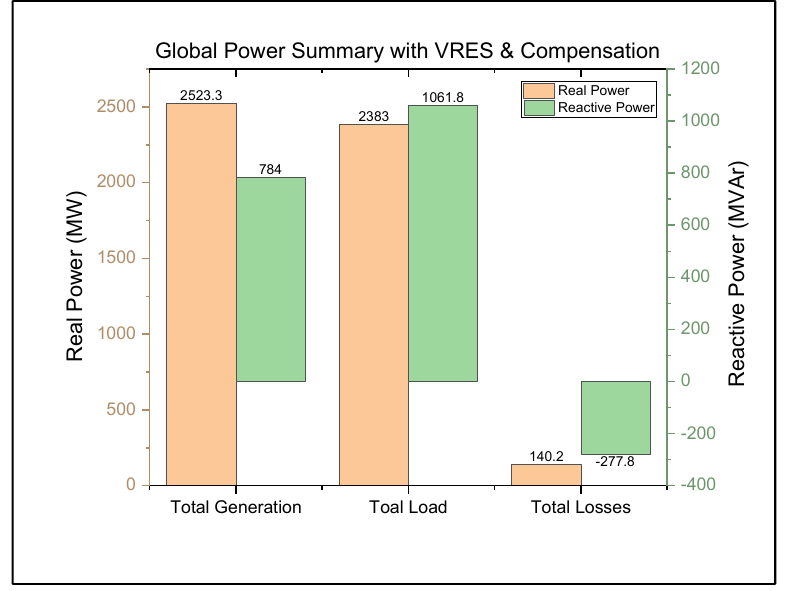
Figure 11. Showing power summary after VRES integration.